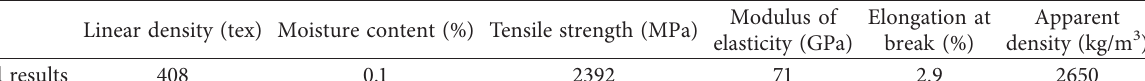
Table 3: Physical and mechanical properties of basalt fibers.